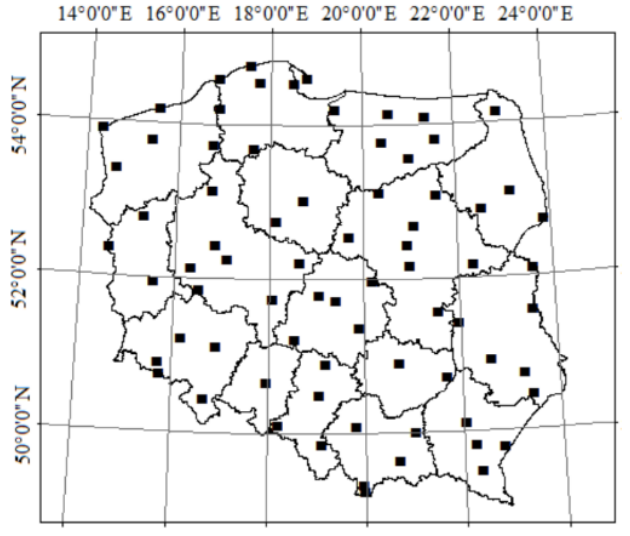
Figure 1. Location of the meteorological stations in Poland that were used in the study.